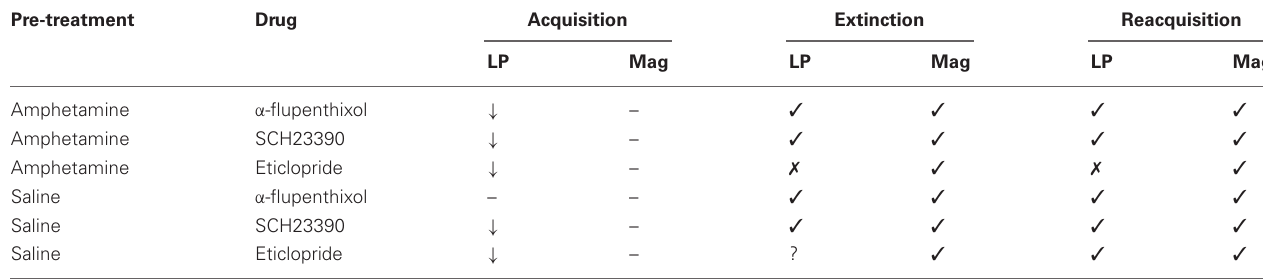
Table 1 | Summary of main experimental